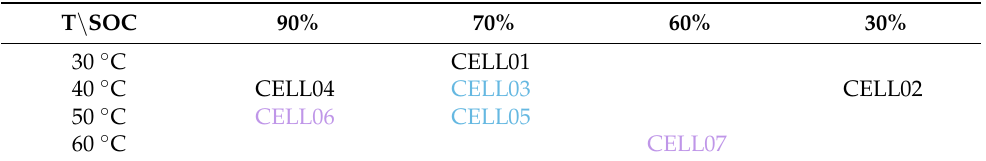
Table 2. Ageing test matrix for LFP/graphite cells. T \